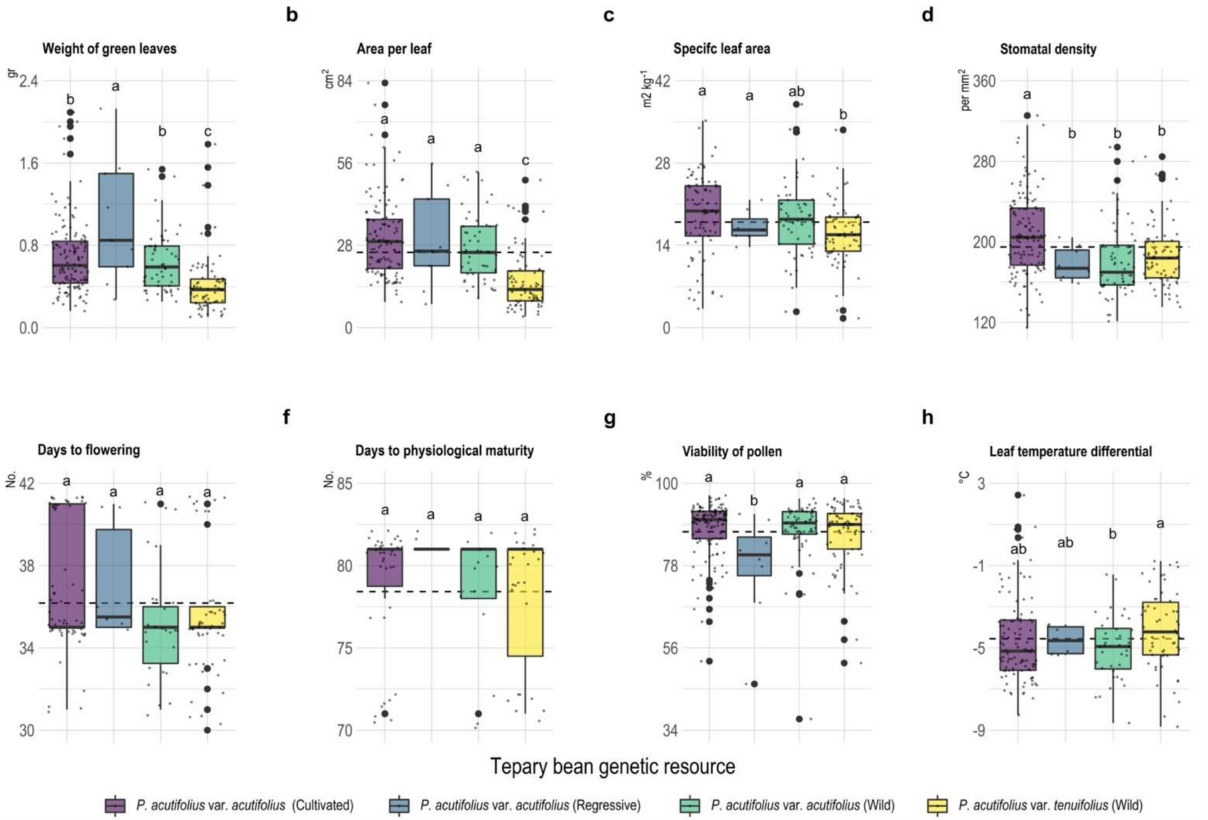
Figure 3. Box plots of the scatter plot for morphological ( a – d ), phenological (days to flowering ( e ) and days to physiological maturity ( f )) and physiological ( g , h ) characteristics of tepary bean genetic resource. Dotted line means the overall mean for each variable. Different letters between tepary bean genetic resource indicate different means ( p <